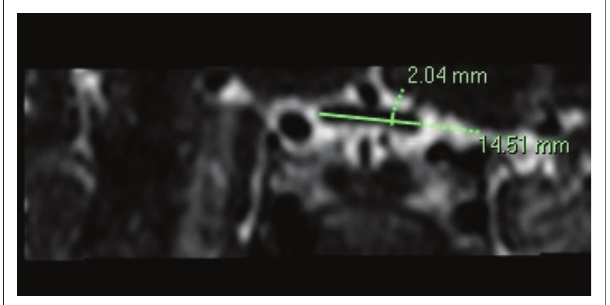
FIGURE 3: Reformatted coronal T2W 3D magnetic resonance imaging demonstrating the measurement technique of the optic chiasm width and height. TABLE 1: Overall measurements of the anterior visual pathway structures. Variable Dimensions Overall mean